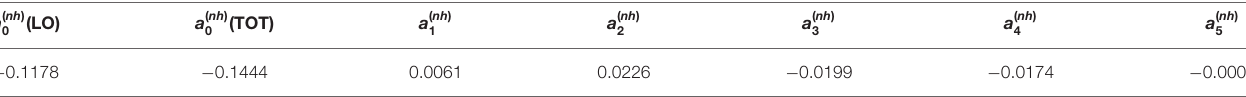
n , p ) 3 H longitudinal asymmetry calculated for the χ EFT NLO PVTC potential described in section 3.4 and the TABLE 7 | Values of the coefficients a ( nh ) i entering the 3 He( E N 3 LO PCTC potential derived in Machleidt and Entem [5] at vanishing neutron beam energy.